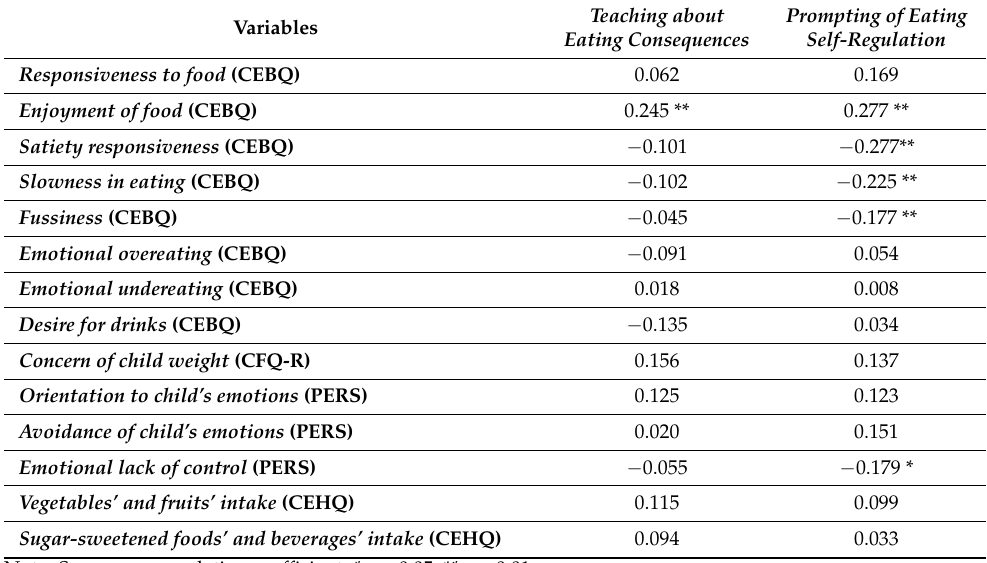
Vegetables’ and fruits’ intake